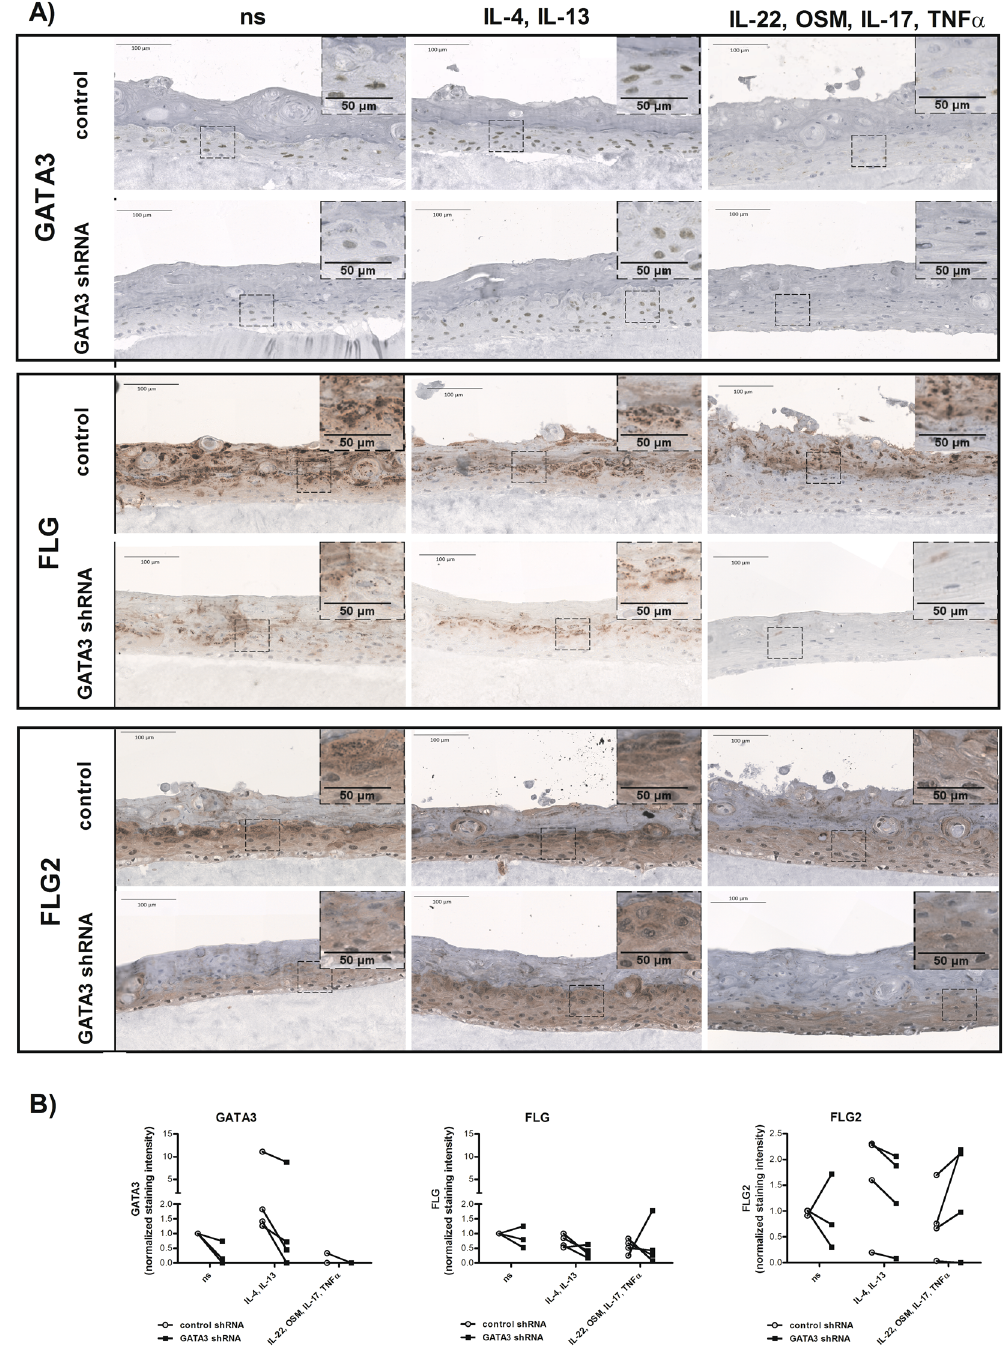
Figure 6. Immunohistochemical analyses of the effect of GATA3 silencing on the protein expression of FLG and FLG2. ( A ) 3D skin equivalents were constructed from GATA3 silenced or control treated cells. The 3D models were incubated for 3 days in the presences of the indicated cytokines (25 ng/ml were used of IL-4, IL- 13, OSM, and IL-17 and 10 ng/ml were used of IL-22 and TNF α ). Afterwards immunohistological staining was performed to detect GATA3, FLG, and FLG2, respectively. Representative examples of 3–4 independent experiments with different donors are shown. ( B ) Immunohistochemical stainings of GATA3, FLG and FLG2 were quantified by using the software cellSense Dimension with Count & Measure Solution (Olympus). The normalized staining intensity of AEC and DAB, respectively, is depicted (normalized to the area of the